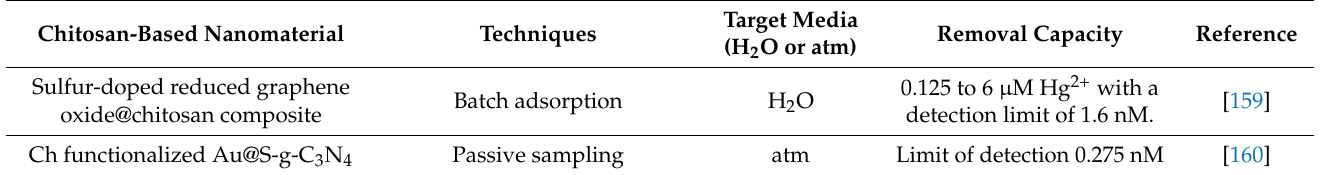
Table 3. Enhancement in modification and applications as a result of chitosan composite